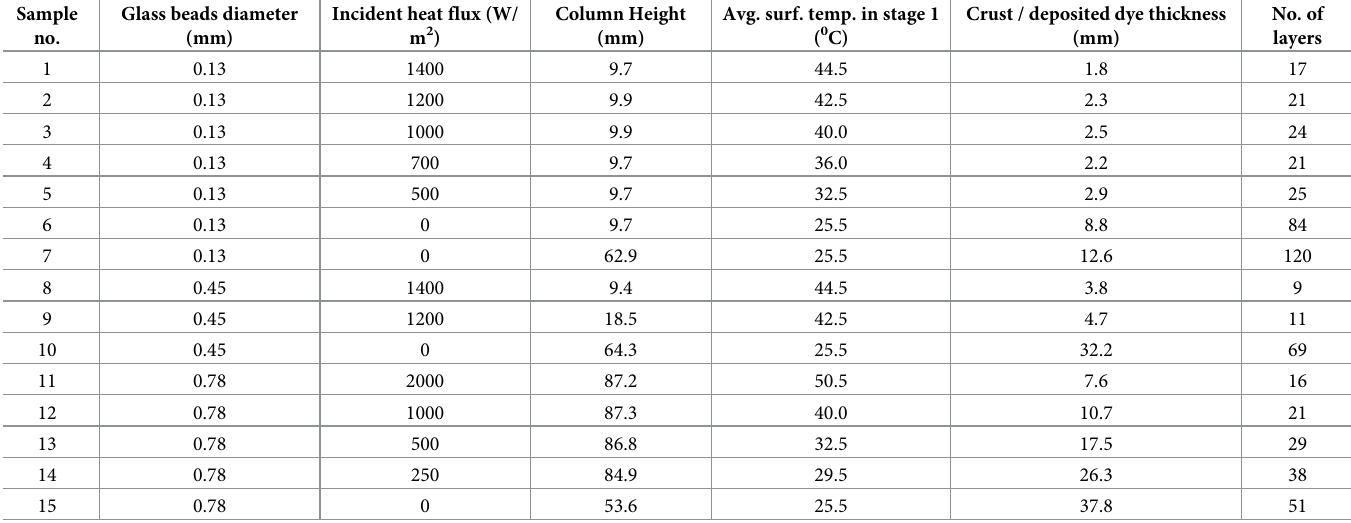
Table 1. Experimental parameters in the present study. Experiments with sample number ‘1–6’ and ‘8’ were conducted in small Teflon boxes, ‘9’ in a medium-sized acrylic container, and ‘7’ and ‘10–15’ in large glass beakers. Hard layer thickness for the corresponding experiments is also mentioned. Average surface temperatures in stage 1 of evaporation are mentioned as a guide. The particles were hydrophilic in all the 15 cases mentioned here. Sample